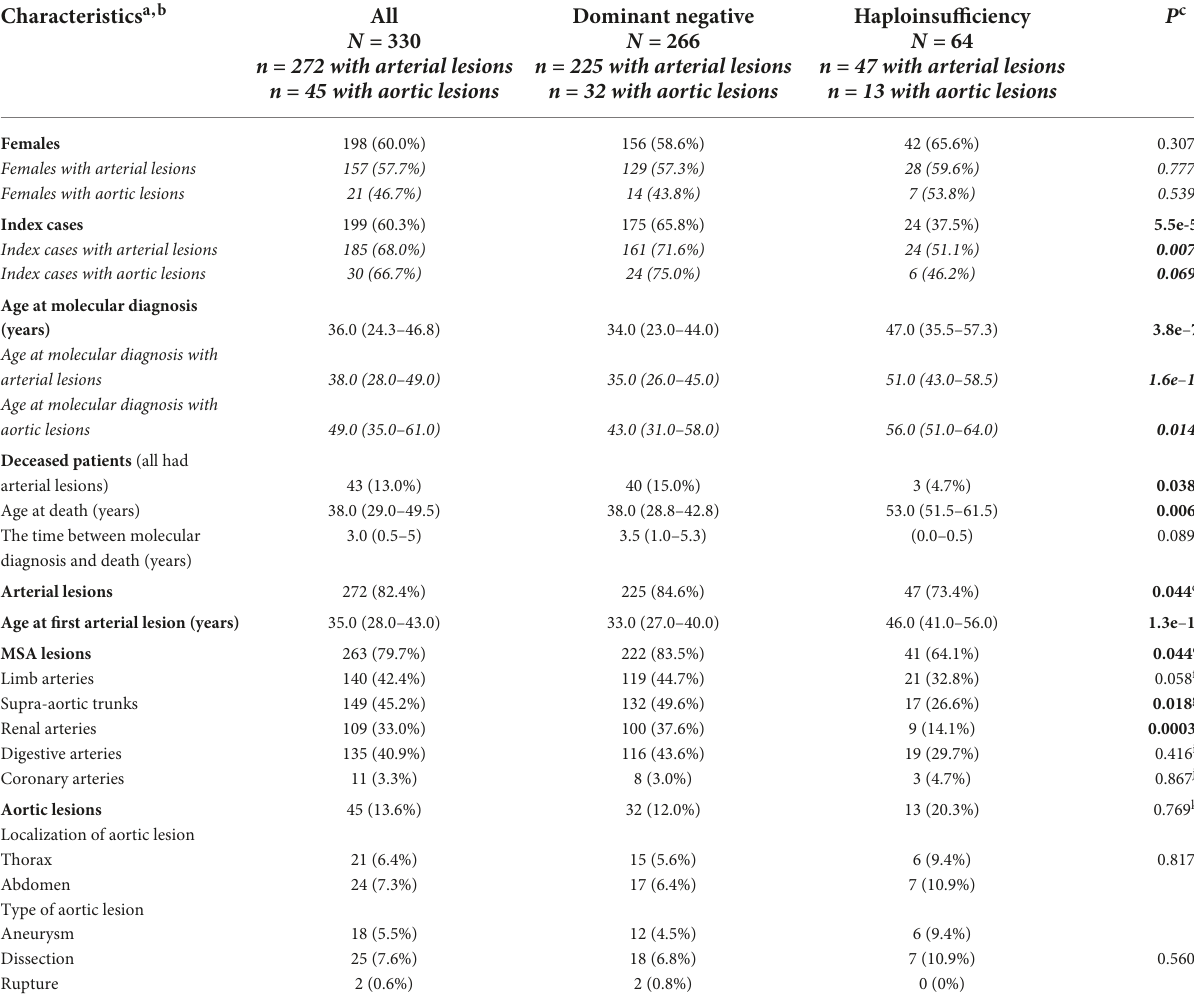
TABLE 1 Demographic and arterial characteristics of N = 330 vEDS adult patients at study according to the type of COL3A1 variants. Characteristics a ,